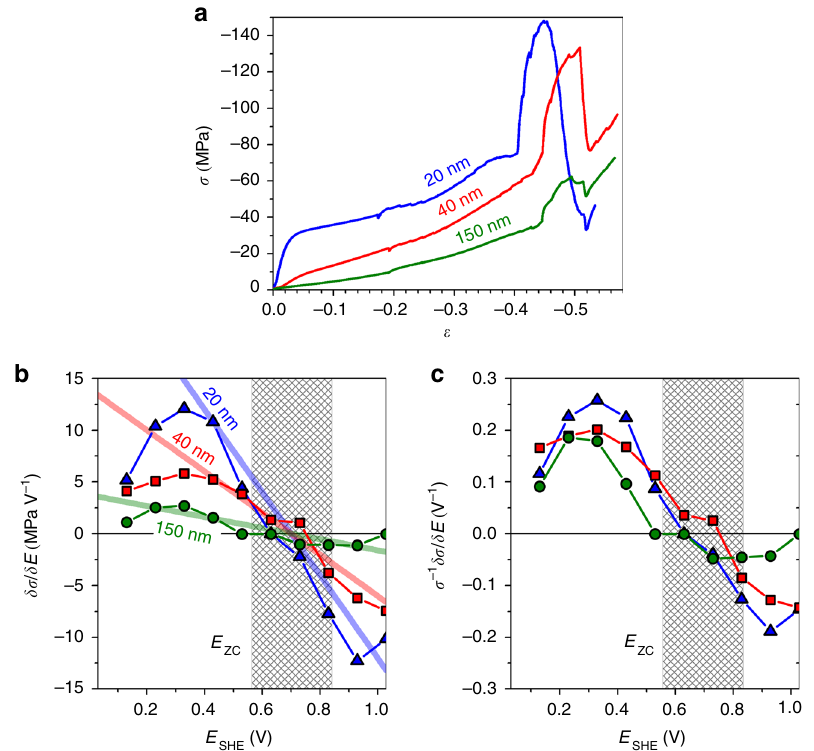
Fig. 5 Experiments with different ligament size. a Flow stress σ vs. strain ε during deformation with strain rate 10 − 5 s − 1 in compression. b Effective response of σ to jumps in the electrode potential, E , determined as δ σ / δ E . Straight lines: prediction by Eq. (12). c The parameter δ σ / δ E is normalized to the actual value of fl ow stress, σ 0 . Note no size-dependent behavior in this case. Shaded: range of potential of zero charge, E zc . Test in 0.5 M H 2 SO 4 ; ligament sizes are indicated by labels